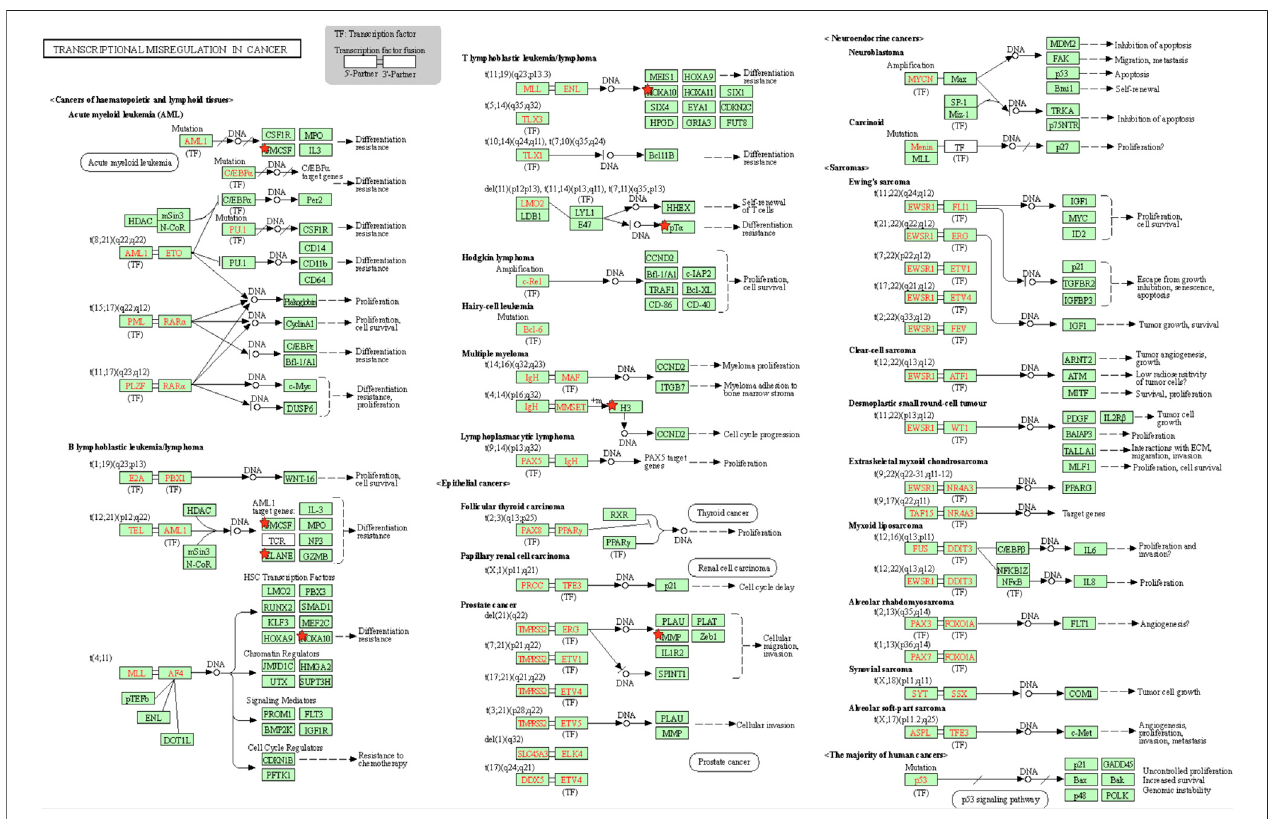
FIGURE 4 | Transcriptional mis-regulation in cancer pathways enriched in